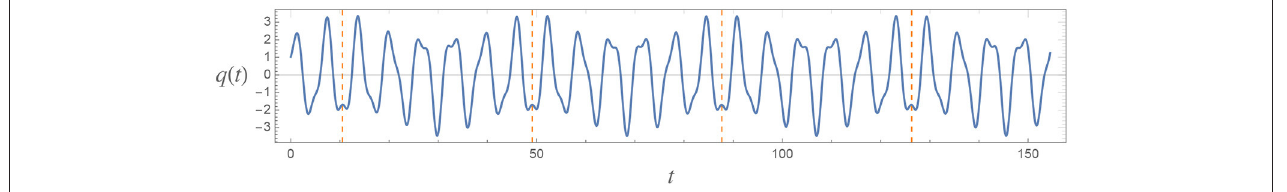
FIGURE 2 | Solution to the equation of motion (4.18) of the Pais-Ulhenbeck model with V ( q ) are set as follows: ω 1 2.1, λ 1.022. The motion appears to be bounded and periodic (the vertical dashed lines indicate the = =